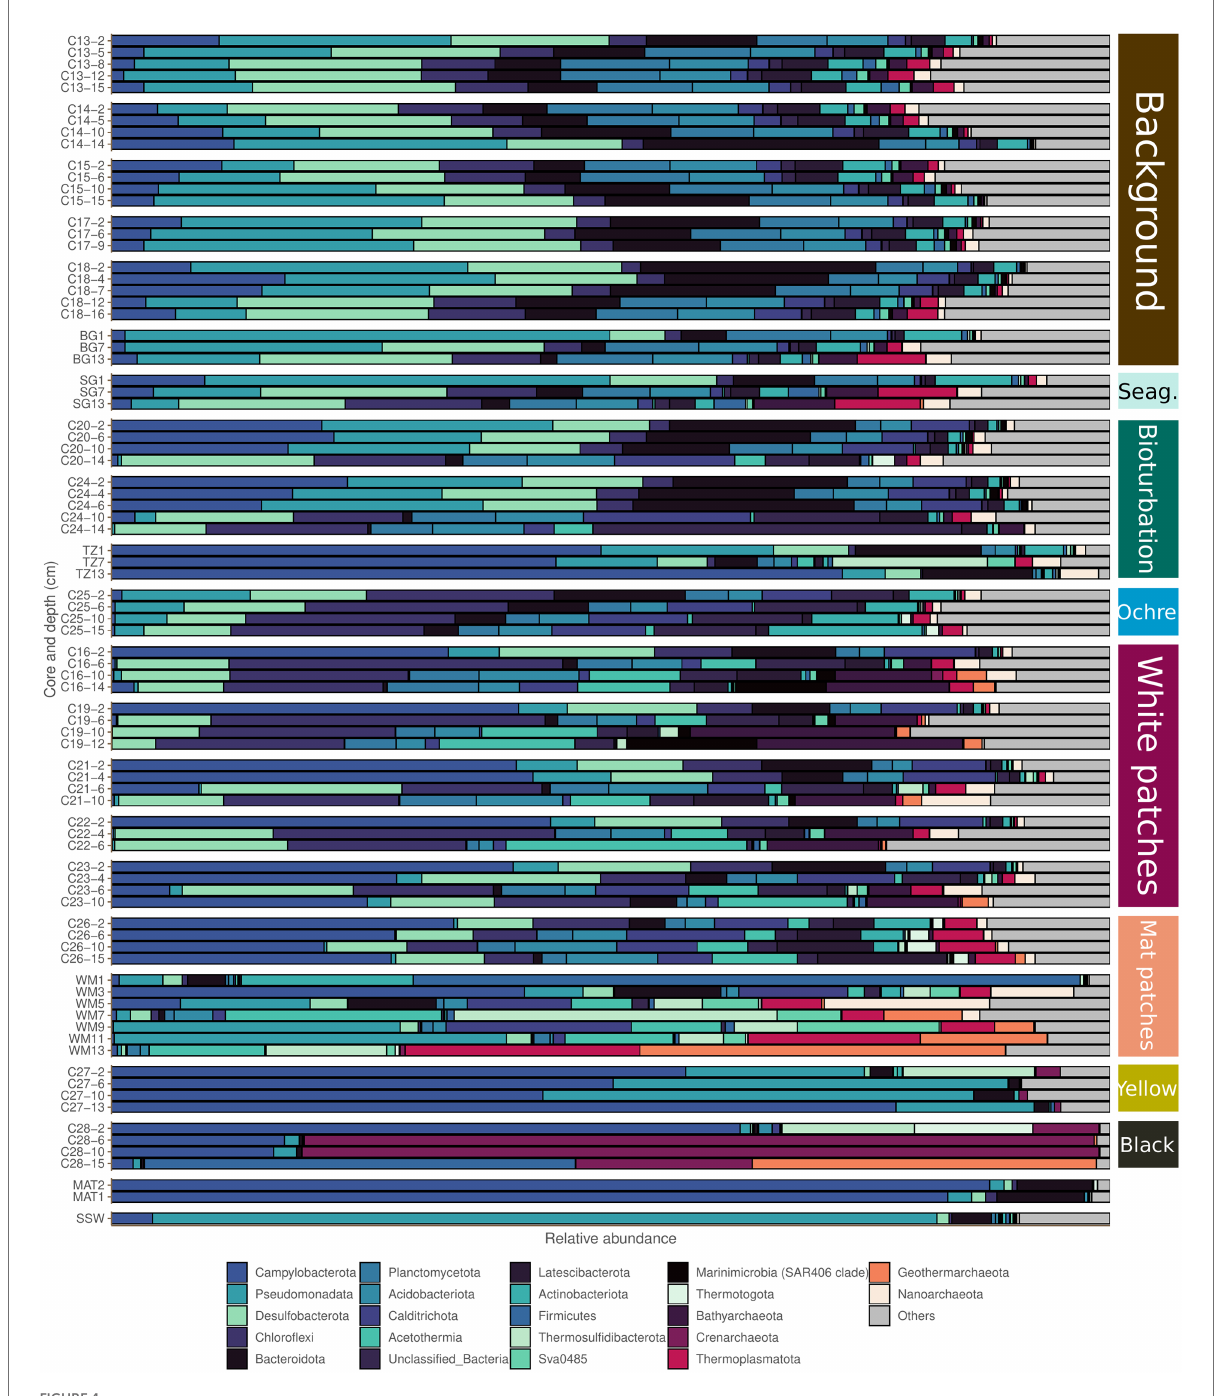
FIGURE 4 Microbial community compositions of the different seafloor types based on 16S rRNA analysis. The barplots show phyla that represent at least 10% of the community in at least one sample from the dataset. The color code to the right for the seafloor types is as in Figure